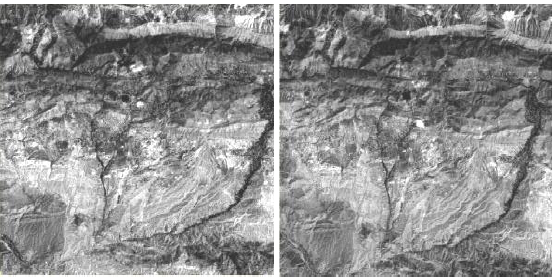
Figure 3. CARTOSAT-1 stereo pair over Roodehen, Iran Virtual control points for the solution of the relative orientation are generated using SRTM data for the area covered by the stereo images. The shaded relief of the SRTM data is presented in Figure 4.